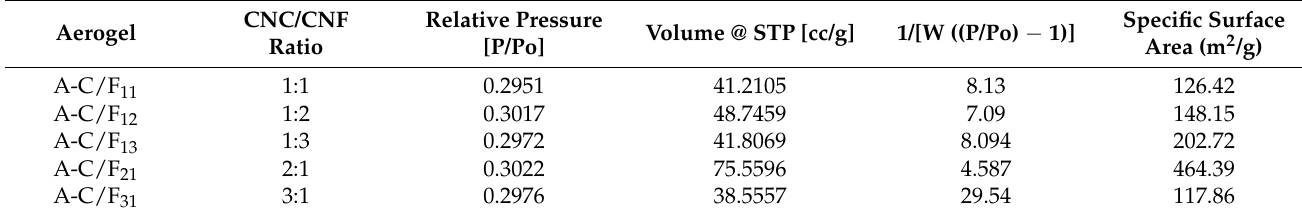
Table 2. Single points’ surface area